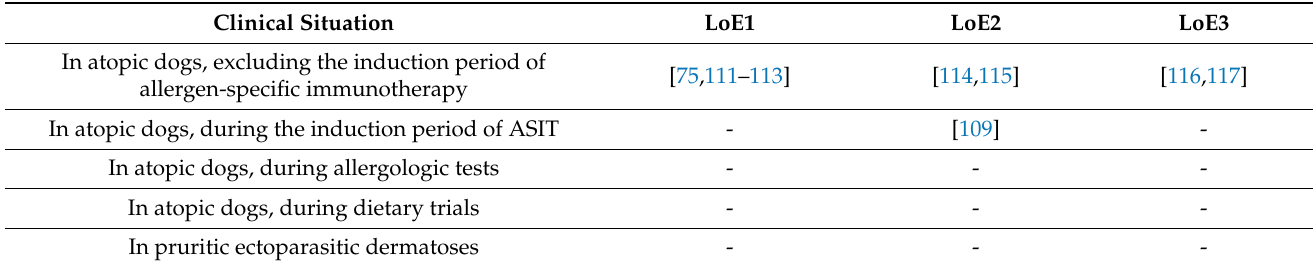
Table 7. Level of evidence (LoE) of individual studies on the use of lokivetmab in different clinical